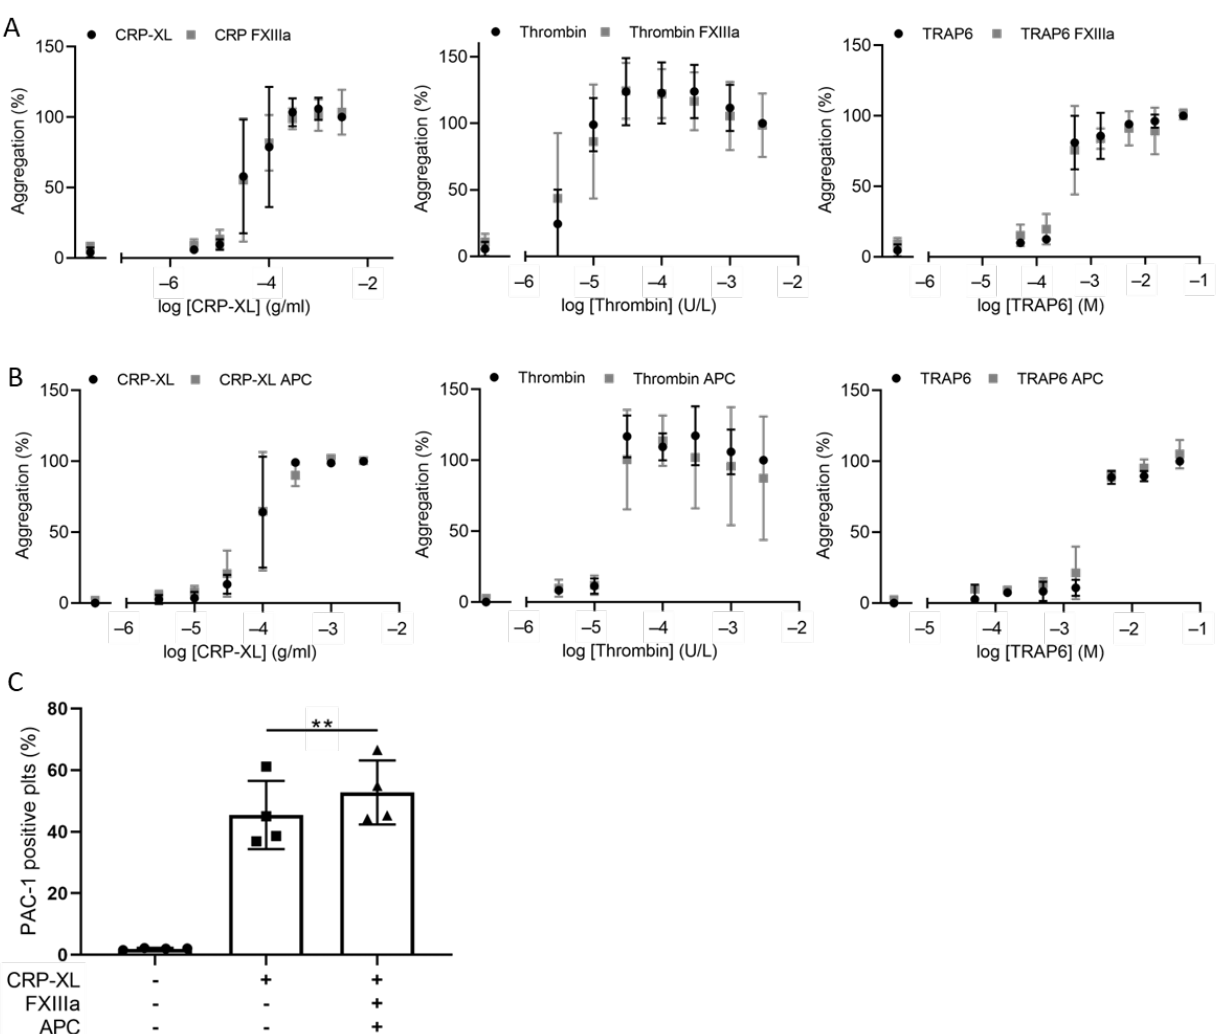
Figure 3. Combinations of coagulation factors (F)XIIIa and anticoagulation factor APC enhance CRP- XL induced platelet activation. ( A , B ) Washed platelets preincubated with vehicle, FXIIIa (10 U/mL) or APC (10 nM) were stimulated with CRP-XL (0.003–3 µ g/mL), thrombin (0.003–3 U/mL) or TRAP-6 (0.05–50 µ M). Platelet aggregation was assessed by well plate-based light transmission changes. All data were scaled relative to aggregation obtained upon highest agonist concentration in the presence of vehicle (100%). Mean ± SD, n = 3; two-way ANOVA. ( C ) Washed platelets were preincubated with vehicle or FXIIIa and APC and activated with a submaximal CRP-XL concentration (0.03–0.5 µ g/mL). Flow cytometry was used to measure activated integrin α IIb β 3 using FITC labelled PAC-1 mAb. Paired t -test, ** p < 0.01, mean ± SD, n =